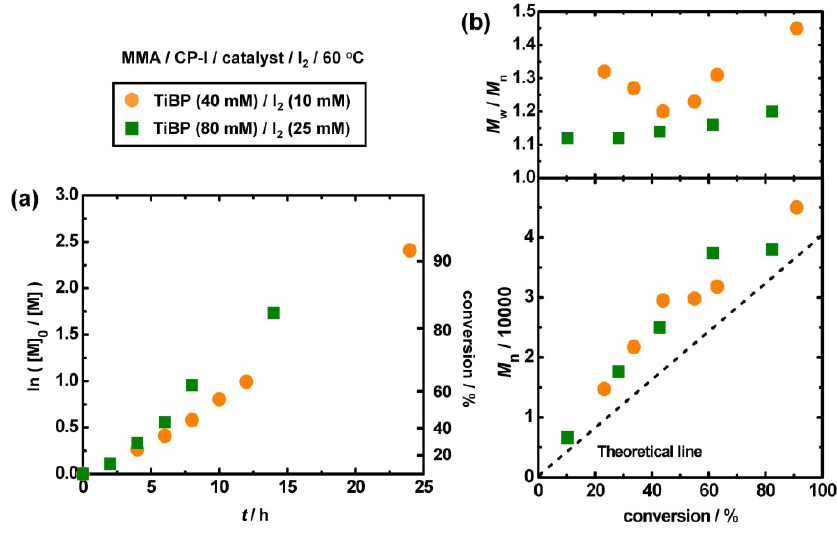
/[M]) vs. t and ( b ) M 0 systems (60 °C) (entries 12 and 13 in Table 1): [MMA] 2